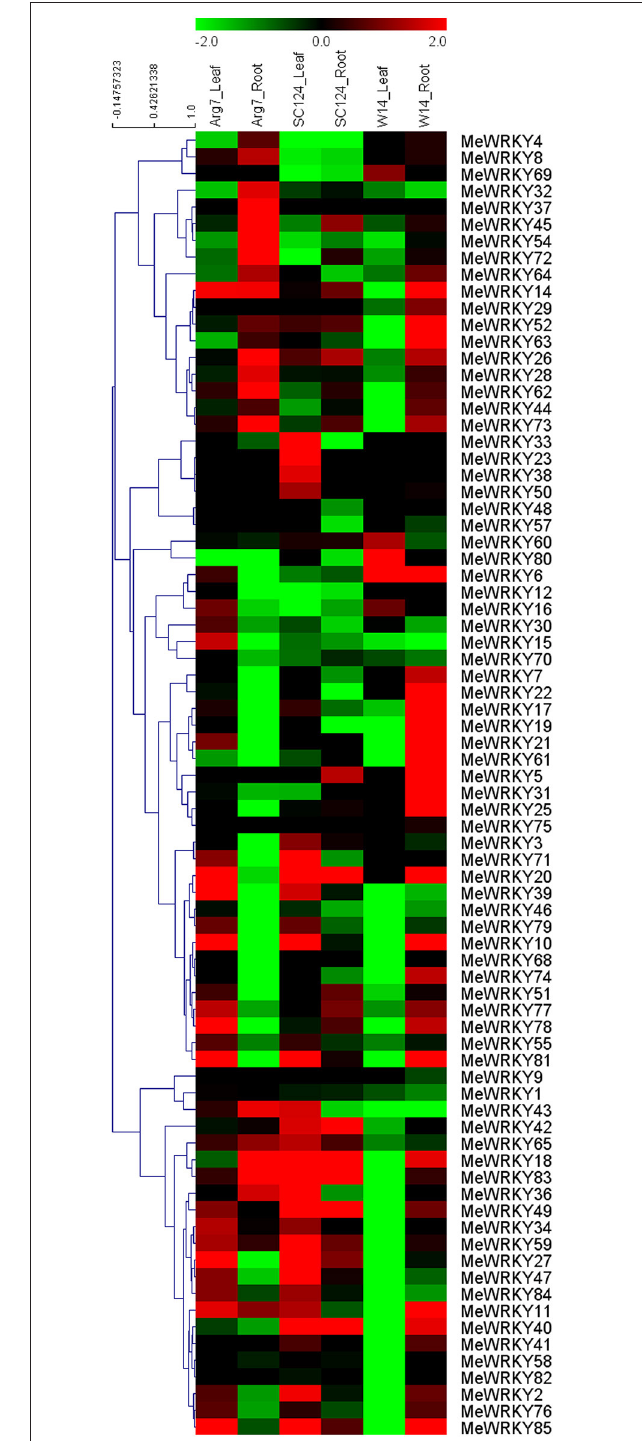
FIGURE 5 | Expression profiles of MeWRKY genes in leaves and roots of three cassava accessions after drought treatment. Log2 based FPKM value was used to create the heat map with clustering. The scale represents the relative signal intensity of FPKM values.